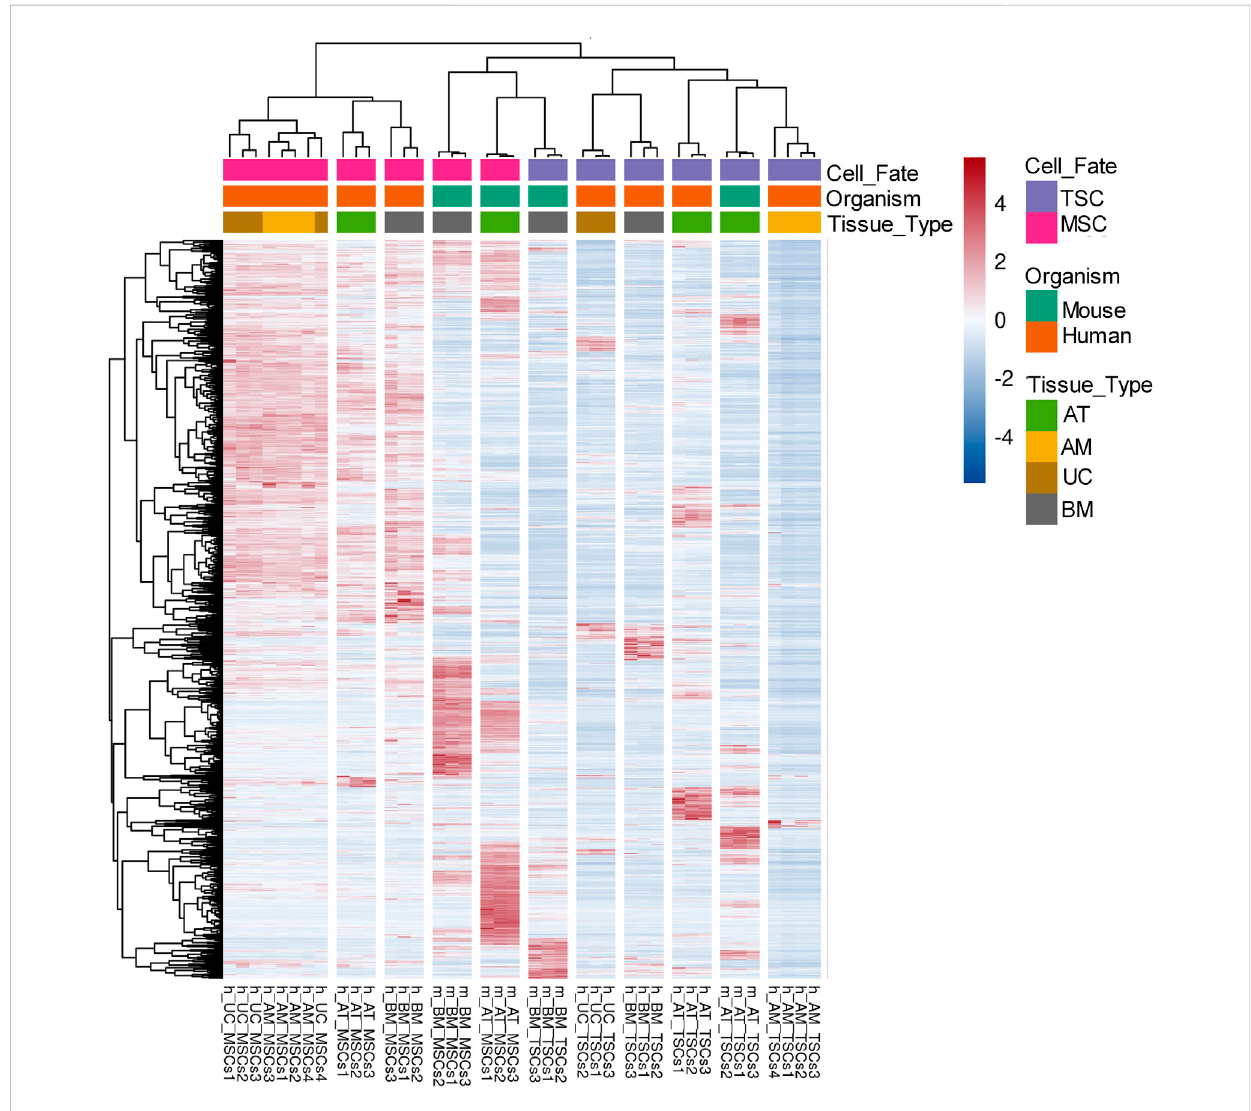
FIGURE 3 Heatmap of theDEGs across all MSCs samples. Heatmapof 1,583 MSCs DEGs between human and mouse showing threemain clusters:a cluster of all human MSCssamples,acluster ofall mouse MSCssampleswith m_BM_TSCs,andacluster ofall theTSCs samples. The normalized expression values are color-coded where red indicates high expression and blue indicates low